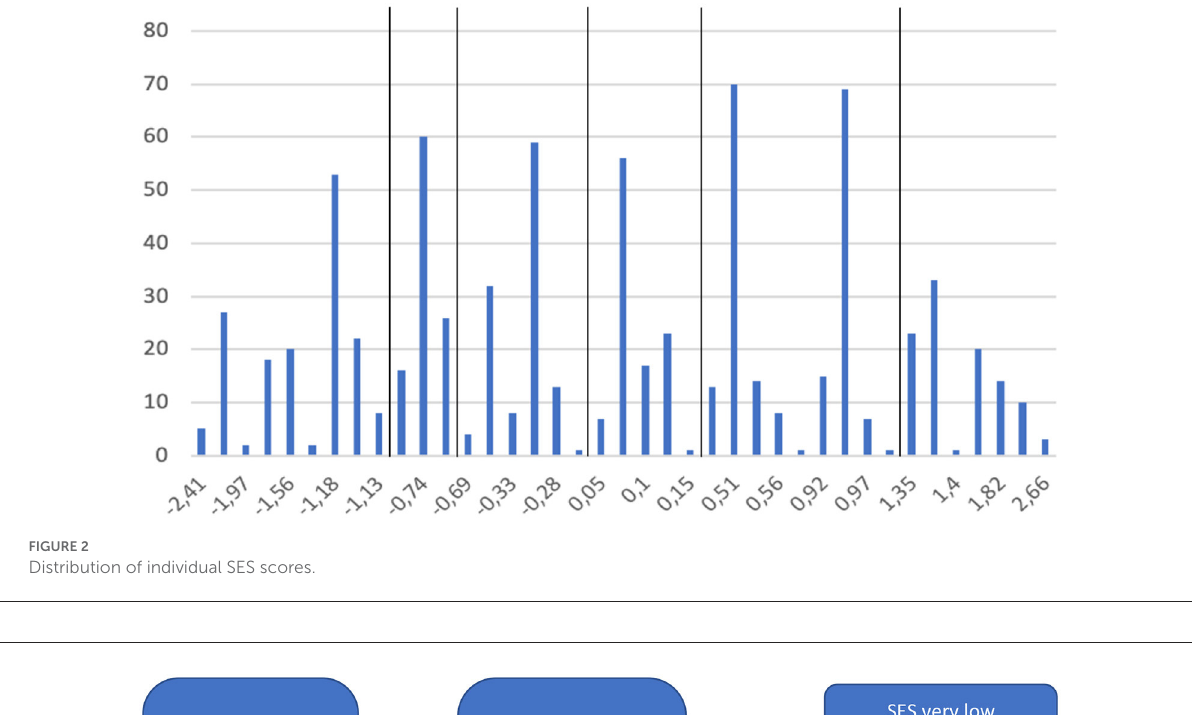
FIGURE2 Distribution of individual SES scores.